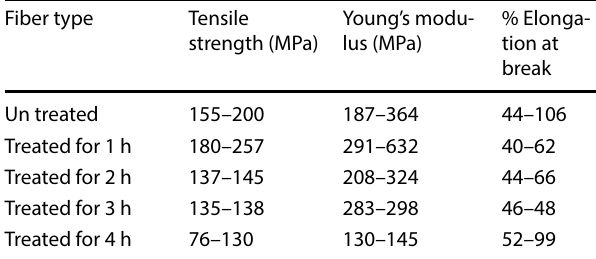
Table 8 Tensile properties of untreated and treated human hair Fiber type